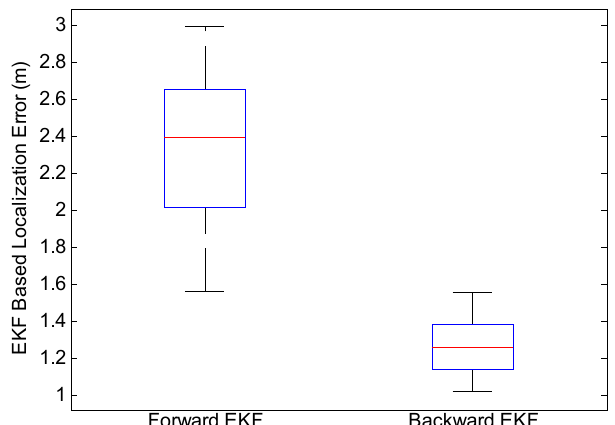
Figure 6. Accuracy Comparison of Forward and Backward EKF.